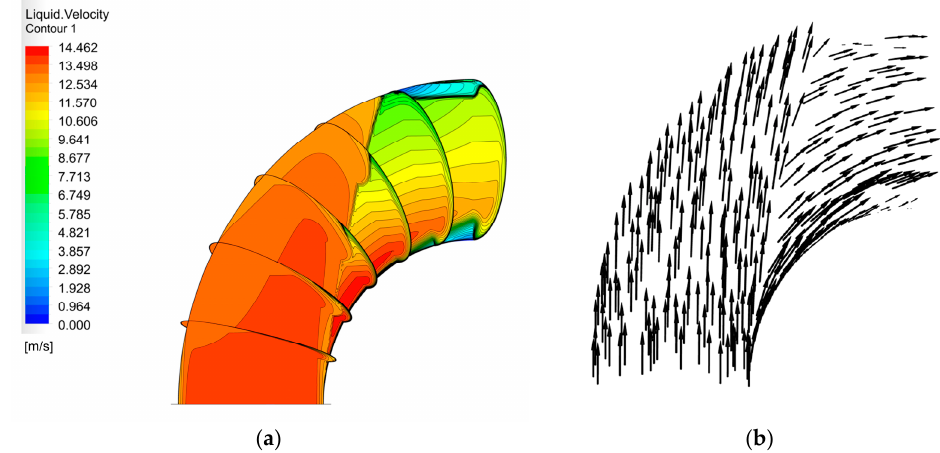
Figure 10. Velocity distribution and streamline of the liquid phase: ( a ) contour; ( b ) vector.